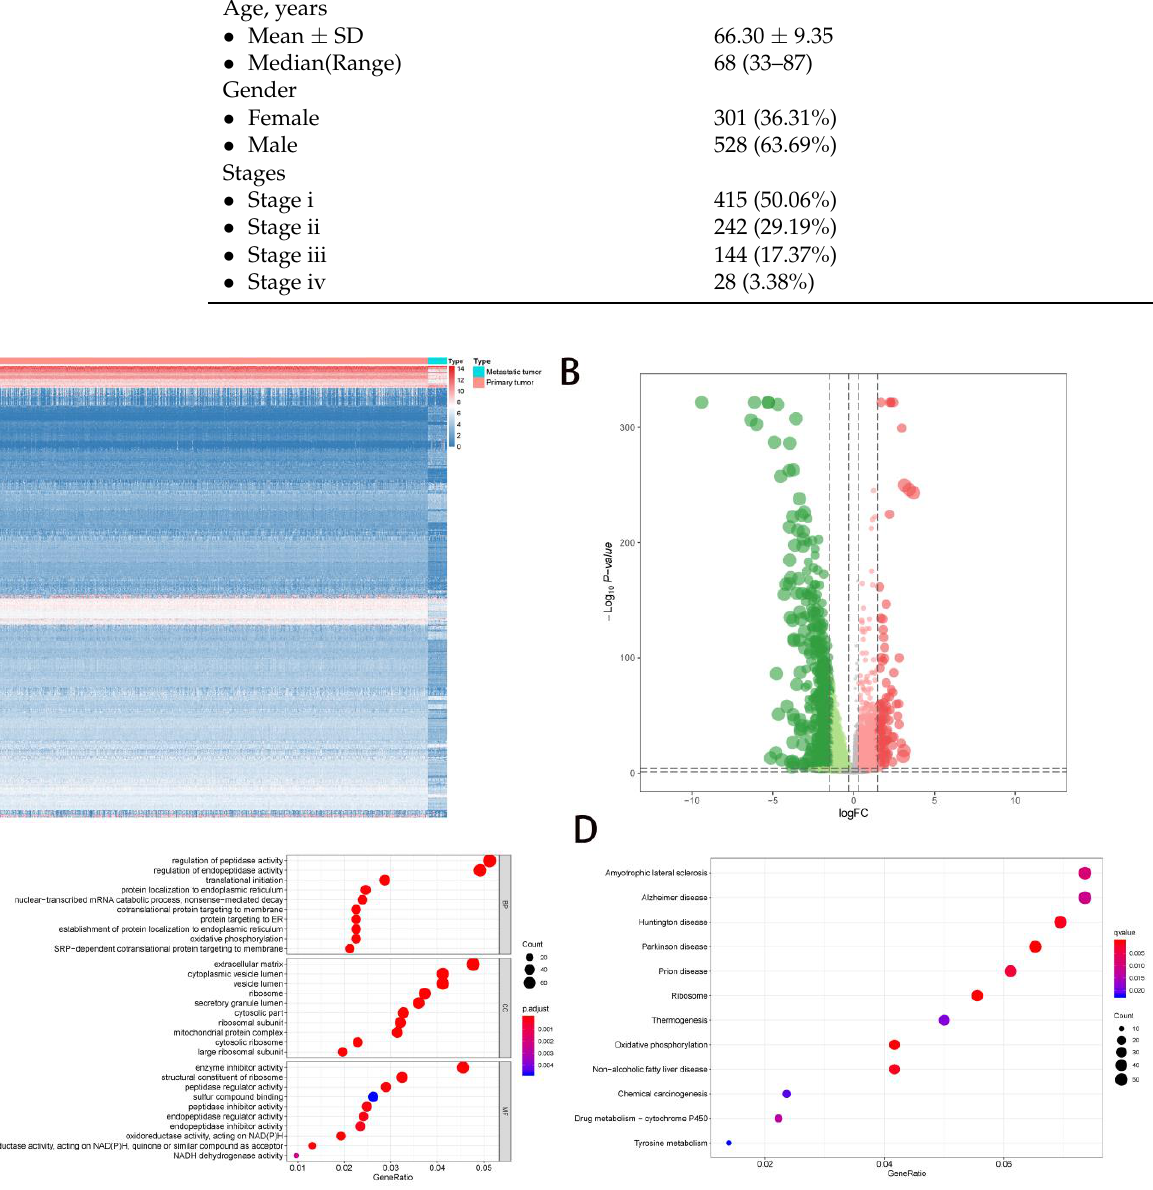
Figure 1. The analysis of DEGs. ( A , B ) DEGs were defined between primary NSCLC and metastatic NSCLC. A total of 1648 DEGs (506 upregulated DEGs and 1142 downregulated DEGs) were defined between primary NSCLC and metastatic NSCLC. In the heatmap ( A ), red color represented primary NSCLC and blue color represented metastatic NSCLC. In the volcano plot ( B ), red dot represented upregulated DEGs and green dot represented downregulated DEGs, the two dashed horizontal lines mark the positions of p -value = 0.05 and p -value = 0.0001, respectively, and the 4 vertical dotted lines mark the positions of log2 foldchange (logFC) = − 1.5, logFC = − 0.3, logFC = 0.3 and logFC = 1.5, respectively. ( C , D ) GO and KEGG pathway enrichment analysis. DEGs enriched in regulation of peptidase activity, extracellular matrix enzyme inhibitor activity and amyotrophic lateral sclerosis significantly. NSCLC, Non-small cell lung cancer; SD, Standard deviation. DEGs, differential expressed genes; NSCLC, Non-small cell lung cancer; GO, Gene Oncology; KEGG, Kyoto Encyclopedia of Genes and